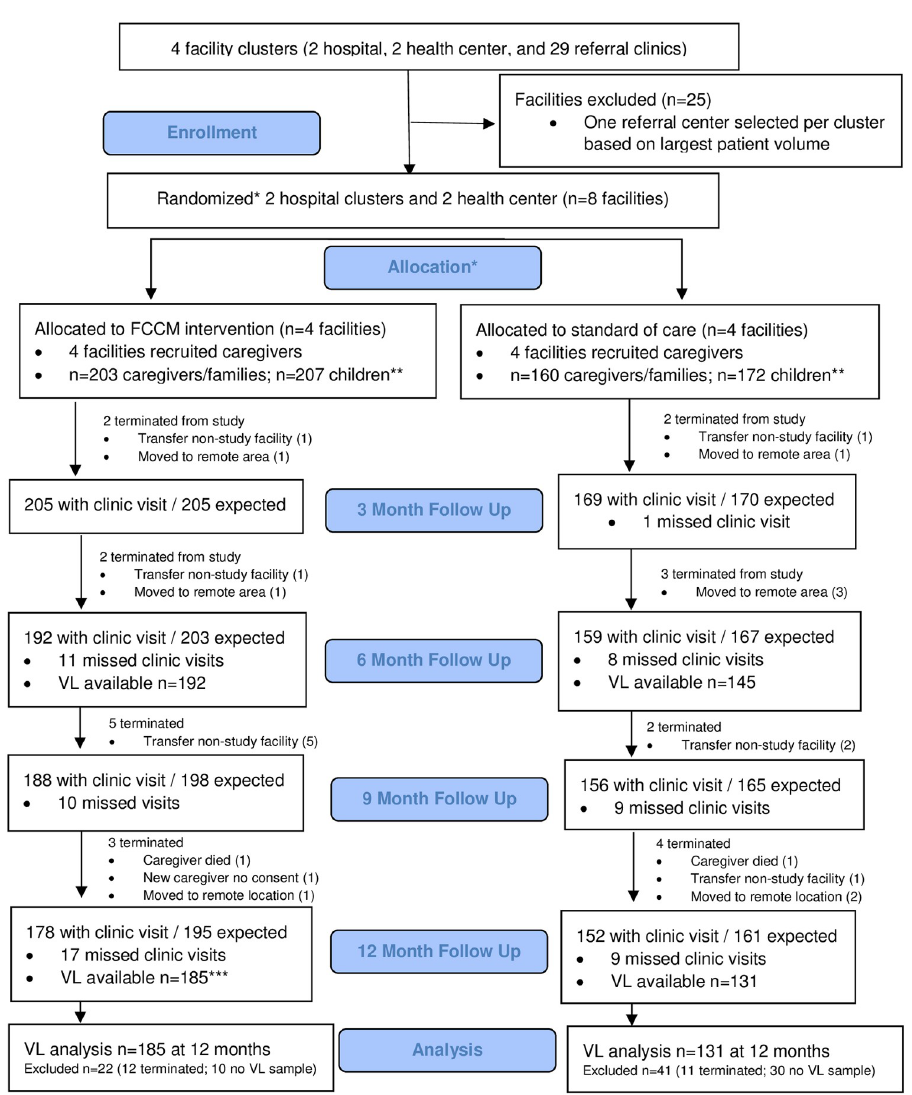
Fig 1. FAM CARE study consort flowchart. � Randomization was at facility cluster level: 2 clusters assigned to FCCM and 2 clusters assigned to SOC groups. �� Each caregiver/family could have more than 1 child. ��� Children could have viral load test drawn for study but missed a clinic